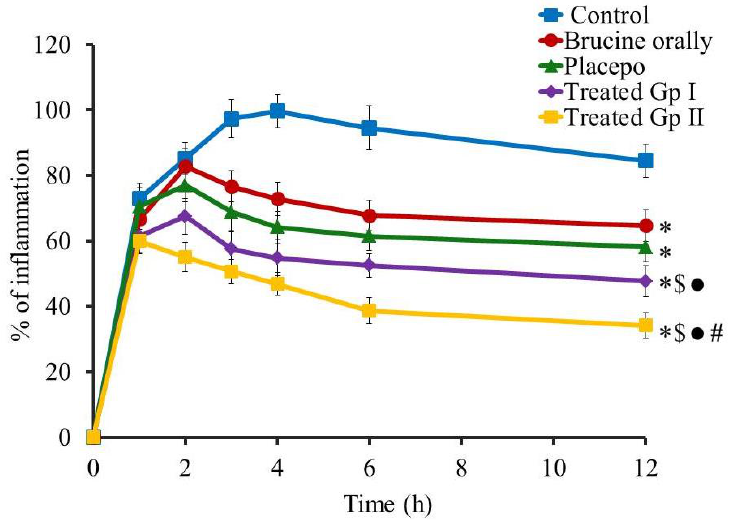
Figure 10. Representing the anti-inflammatory effect of various formulations on rat hind paw edema. Results are expressed as mean with the bar showing SD (n = 6). * p < 0.05 versus control-treated group; $ p < 0.05 versus Brucine orally treated group; ● p < 0.05 versus placebo treated group and # p < 0.05 versus treated GP I.